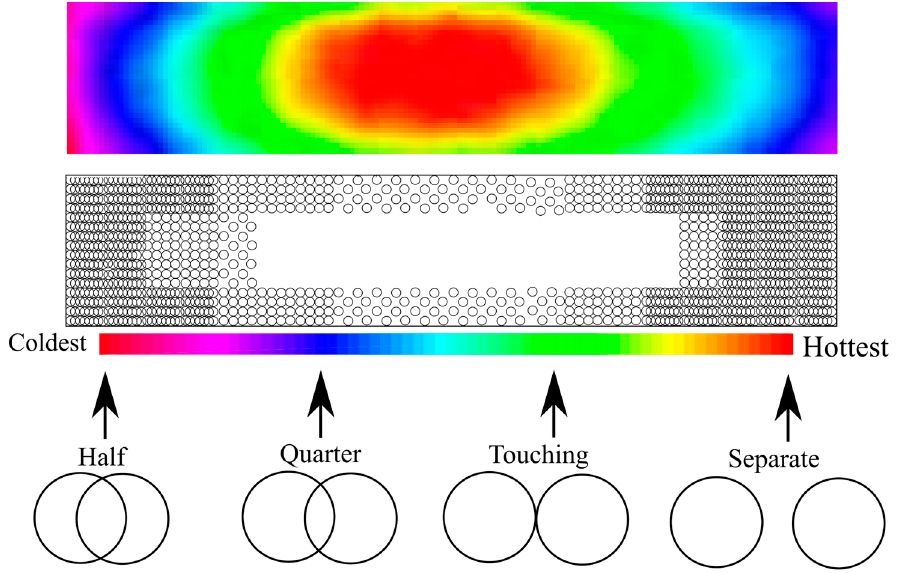
Figure 10. Diagram depicting a stylized image of the element processing model transferring a thermal image of an element into a processing map used by the laser in one cycle with the laser pulses shown by the black circles.